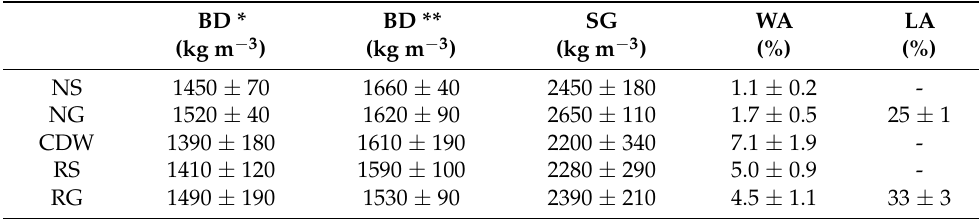
Table 2. Average mechanical and physical properties (n = 10) of aggregates. Uncertainties given as standard deviation of the mean: u = (S x /n 1/2 ), S x being the standard deviation of the samples. BD * BD ** (kg m − 3 ) (kg m − 3